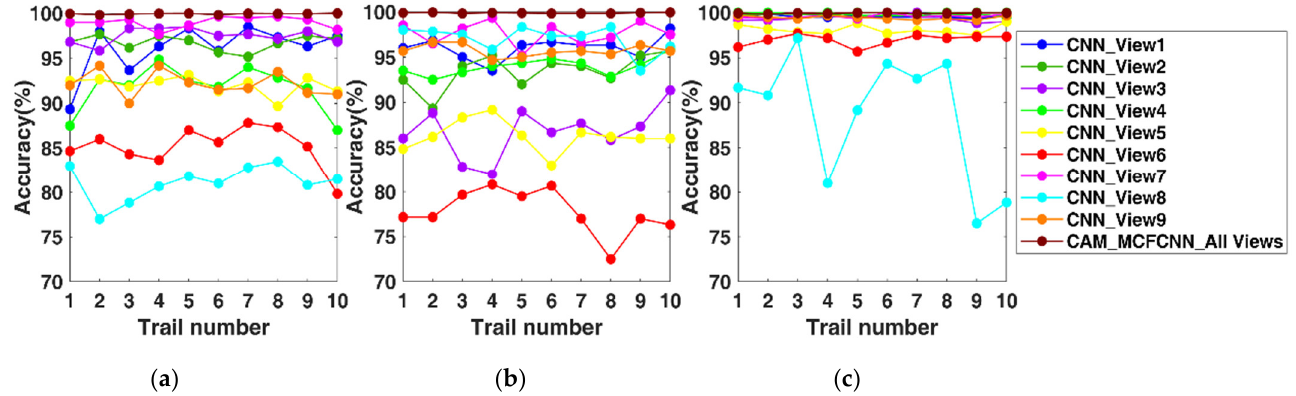
Figure 6. Diagnostic accuracy of ten experiments with single-channel convolutional neural networks (CNN) based on single-view data and CAM_MCFCNN based on multi-view data on test sets A ( a ), B ( b ), and C ( c ), respectively.